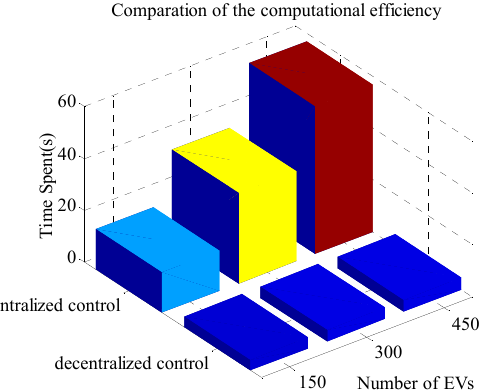
Figure 9. Comparison of computational efficiency.